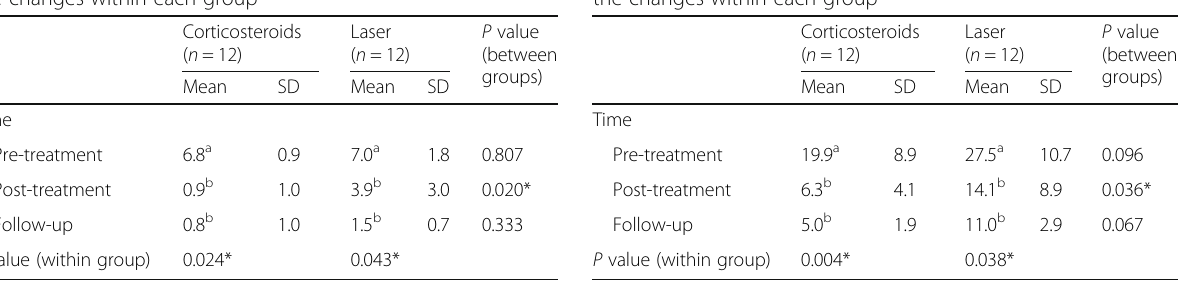
Table 2 Mean, standard deviation (SD) values, and results of comparison between VAS scores in the two groups as well as the changes within each group